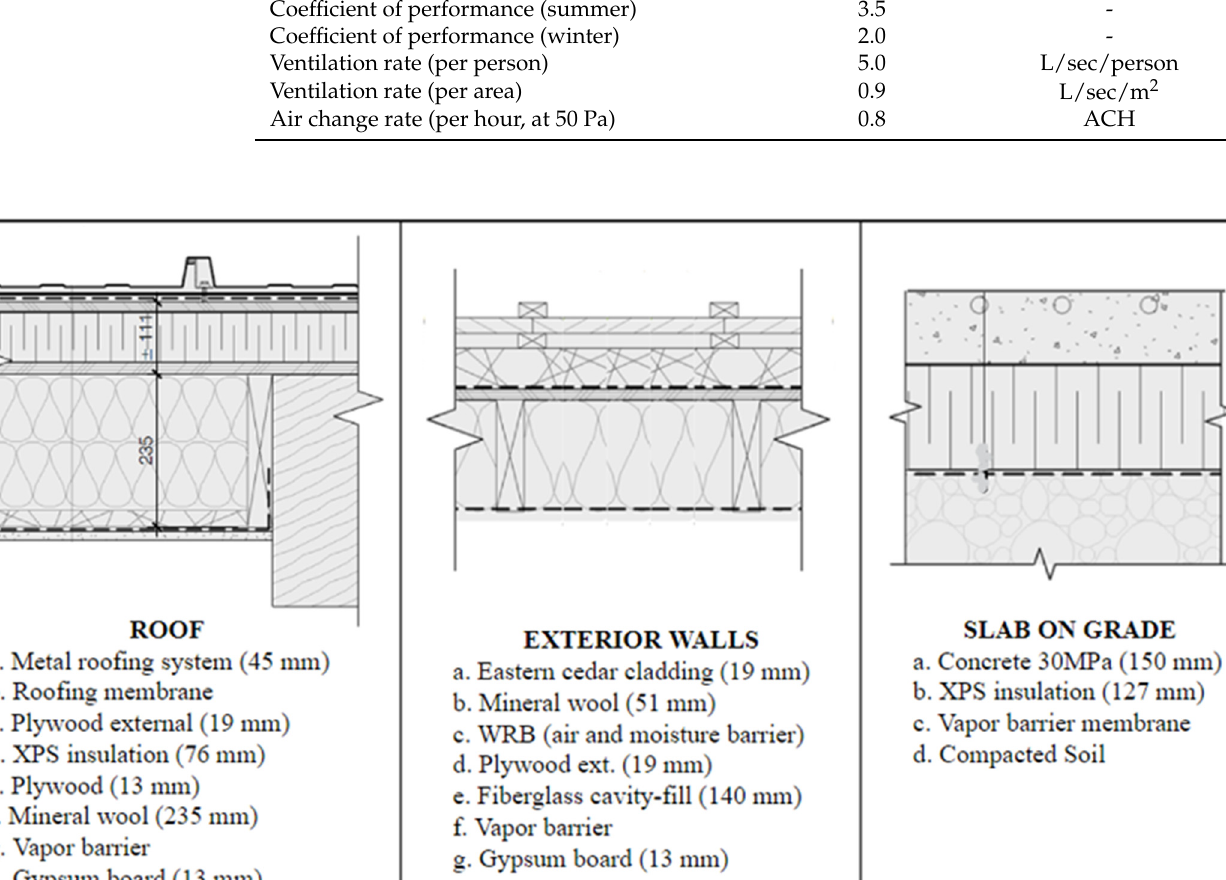
Table 2. U-values (W/m².K) for FBL.